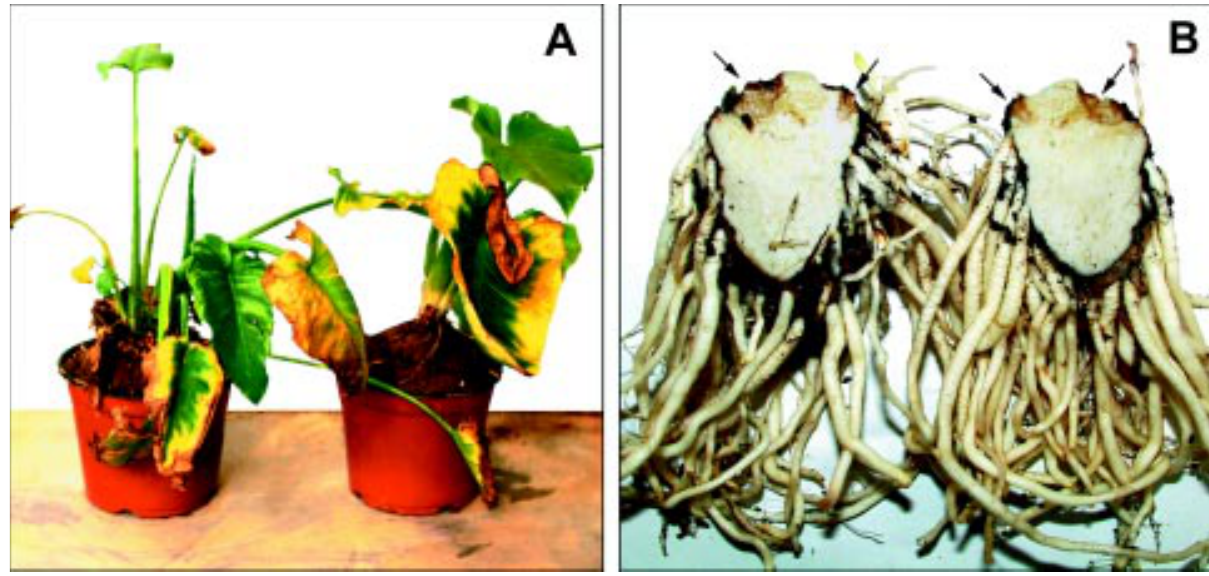
Fig. 1. Symptoms caused by Pectobacterium carotovorum subsp. carotovorum on calla ( Zantedeschia aethiopica ) plants. (A) Infected calla plants showing leaf wilting and yellowing. (B) Section of an infected calla tuber showing soft rot symptom (see